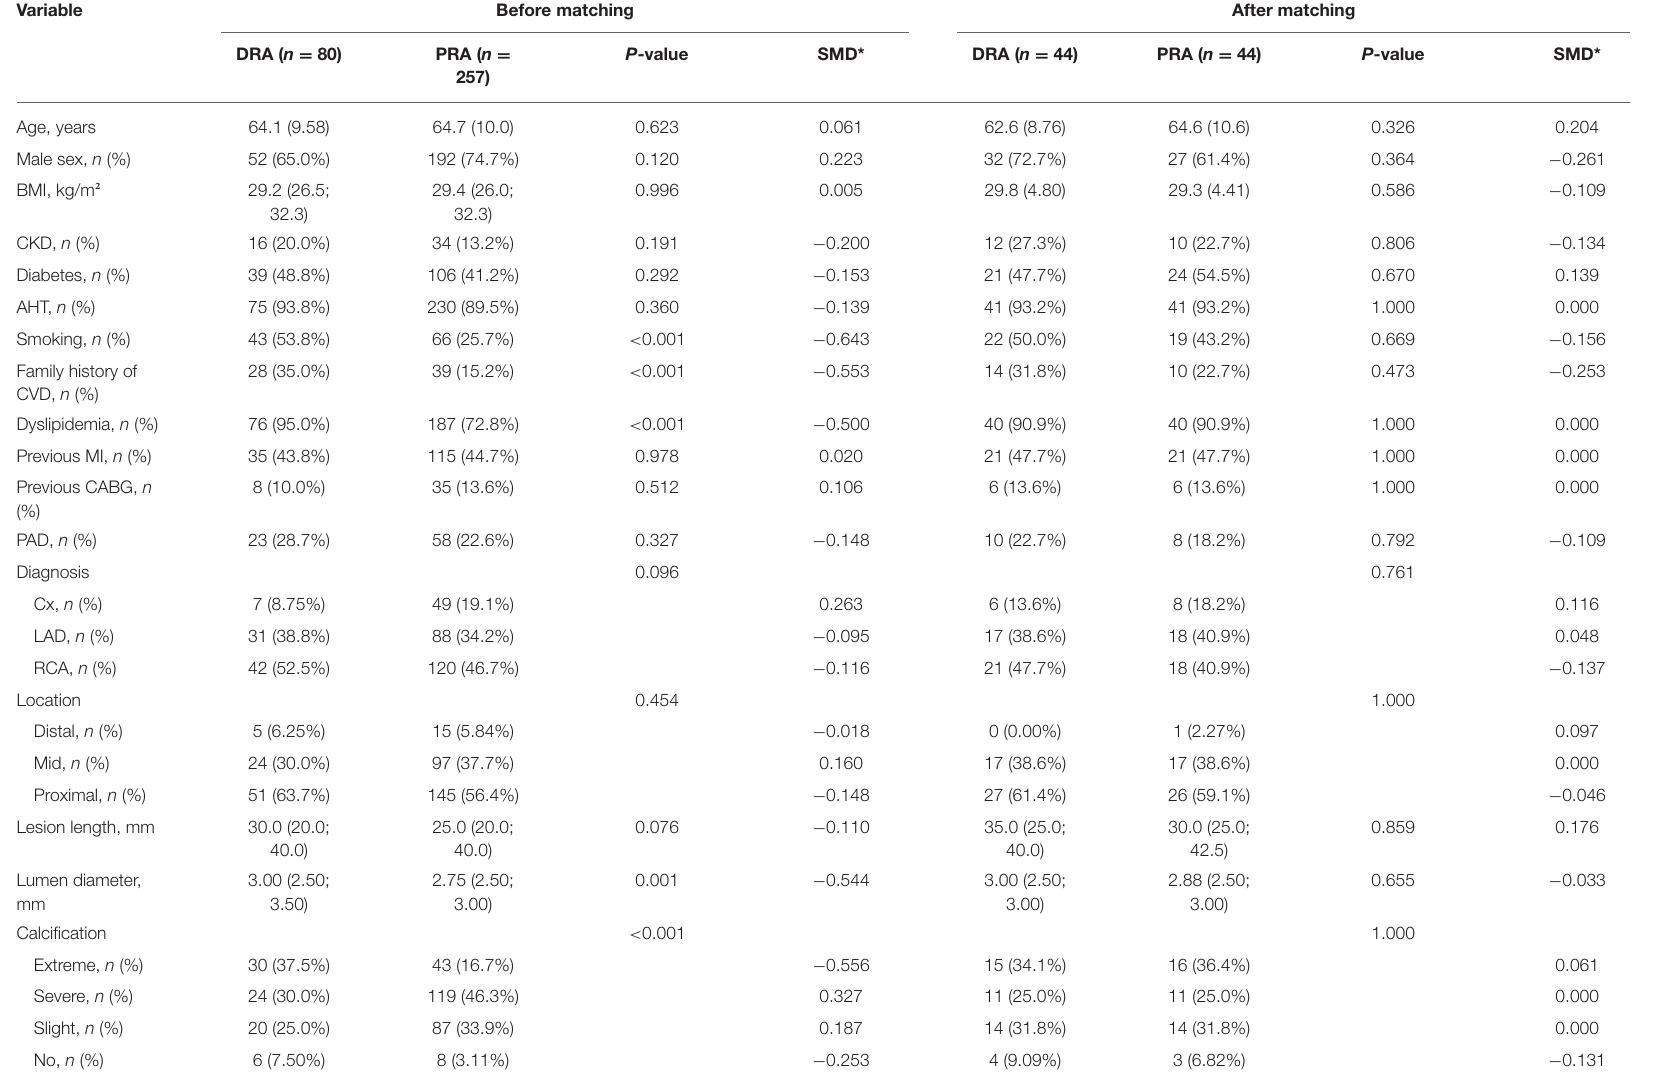
TABLE 1 | Baseline characteristics before and after propensity score